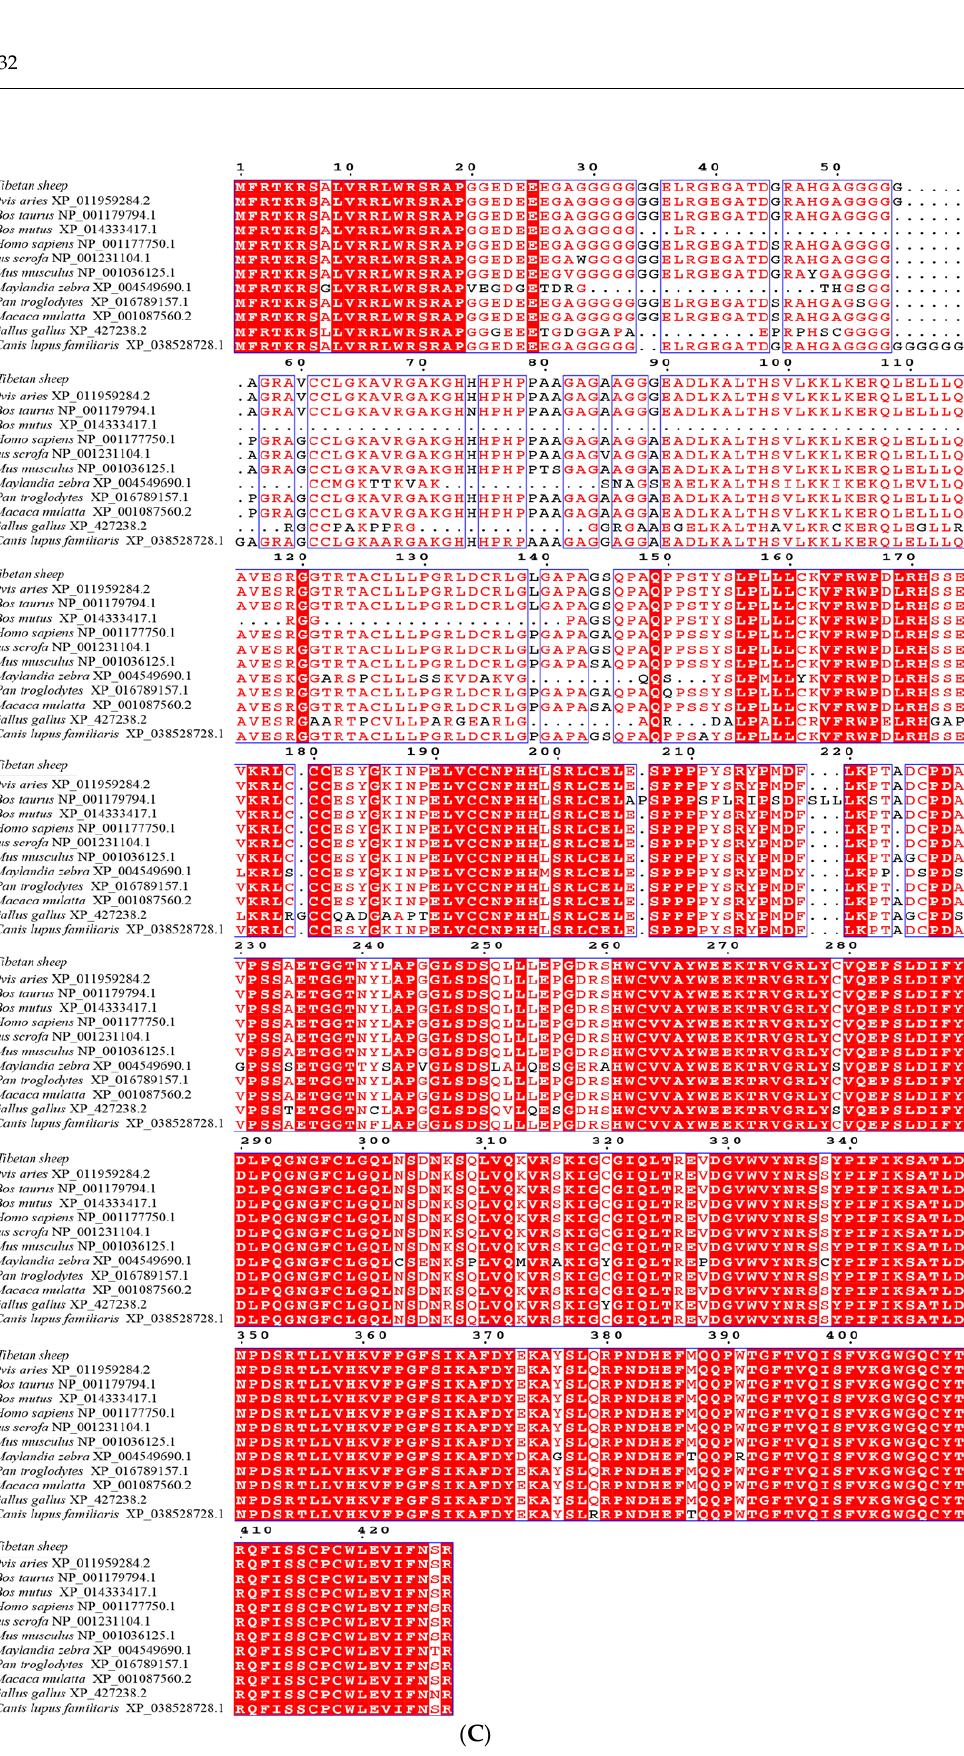
Figure 2. Amino acid sequence alignments of SMAD4 ( A ), SMAD5 ( B ) and SMAD7 ( C ) form Ovis aries . Bos Taurus , Bos mutus , Homo sapiens , Sus scrofa , Mus musculs , Maylandia zebra , Pan troglodytes , Macaca mulatta , Gallus gallus and Canis lupus familiaris